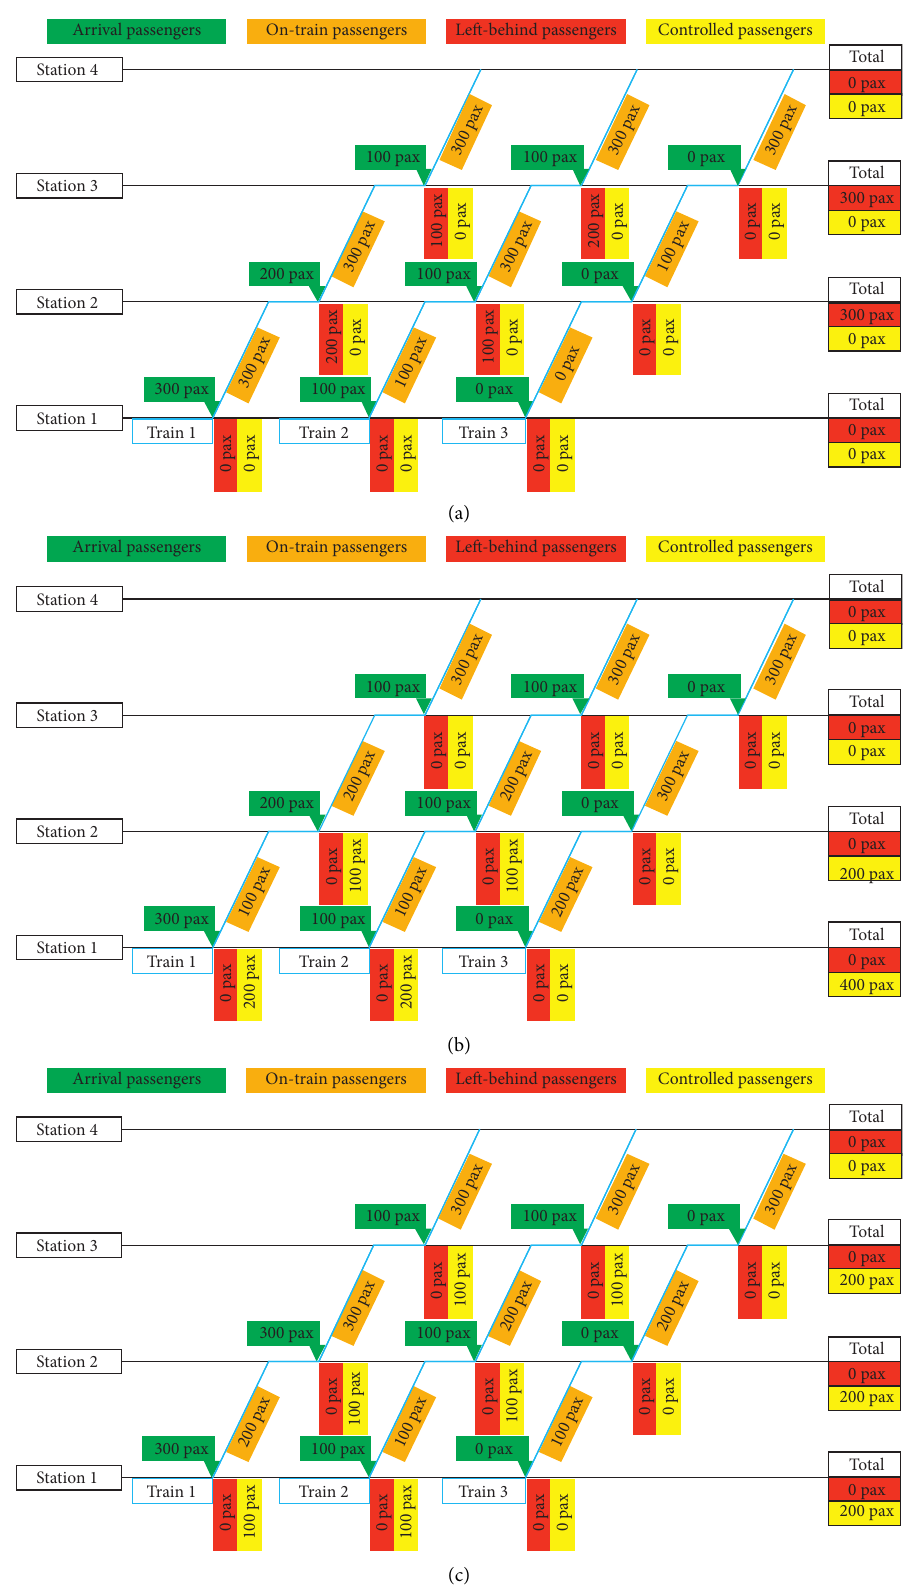
Figure 17: An example with different forms of flow control strategy. (a) Without any flow control strategy. (b) With nonequilibrium flow control strategy. (c) With equilibrium flow control